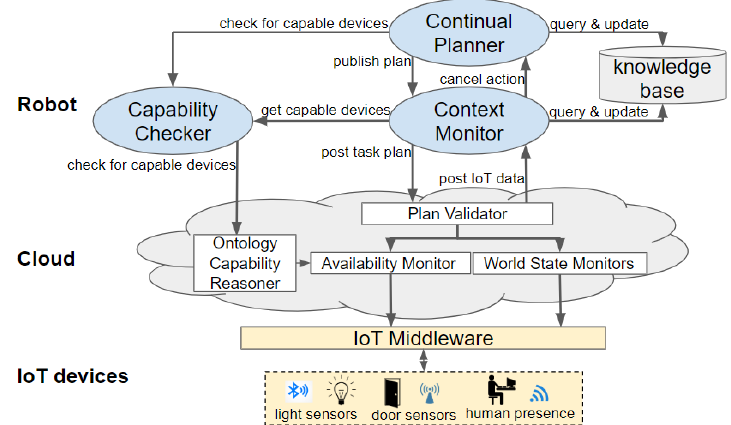
Figure 2. During planning, external module calls check if any device is capable of performing an action by calling a service running in the Capability Checker, which queries the cloud for capable devices and caches the results. The Context Monitor queries this when a plan has been generated, to know which device(s) should perform which action. The plan (containing the list of actual device) is sent to the cloud, which is monitoring the state of the environment and the devices. Any Internet of Things (IoT) data relevant to the robot’s plan is sent back to the robot and inserted into the robot’s knowledge base. If this information will cause the robot’s plan to fail, its current action is cancelled forcing the state to be (re-)estimated and replanning to be